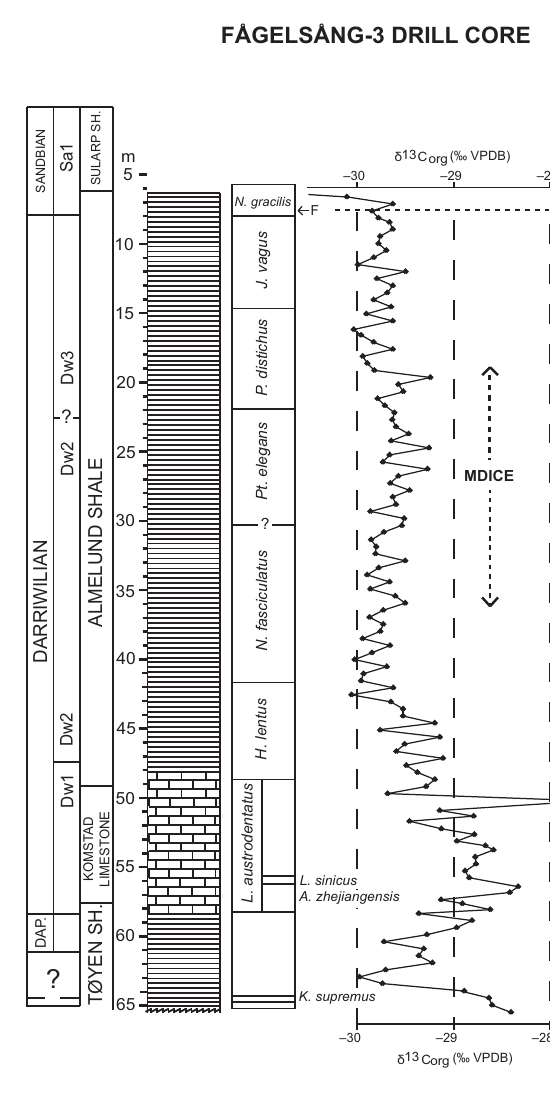
Fig. 5. The δ 13 C org isotopic curve and graptolite biostratigraphy through the Röstånga­2 drill core (to the left) and comparison between the δ 13 C org curves through the Darriwilian dark shale successions in the Röstånga­2 and Fågelsång­3 drill cores. Note the presence of the Fågelsång Phosphorite (F) just above the 20­m level in the Röstånga­2 drill core. The m­levels refer to the drill core depth and not the stratigraphical thickness. A subdued MDICE has been recorded in the isotope curves of both drill core successions, but the base and top of the MDICE are not precisely marked in the Fågelsång­3 core. In the Röstånga­2 core, the MDICE ranges upwards from the lower–middle Pterograptus elegans Zone to near the top of the Darriwilian sequence. In the Fågelsång succession, the MDICE appears to start slightly earlier. Also note the presence of the negative LSNICE in the Nemagraptus gracilis Zone in the Sularp Shale in the uppermost portion of the Röstånga­2 drill core. Both isotope chemostratigraphy and graptolite biostratigraphy suggest that the bottom of the Röstånga­2 drill core succession corresponds to a stratigraphic level in the Holmograptus lentus Zone somewhat above the Komstad Limestone in the Fågelsång­3 succession. As indicated in the text, the presence of this distinctive carbonate unit in the Röstånga area remains uncertain. P . dist., Pseudamplexograptus distichus